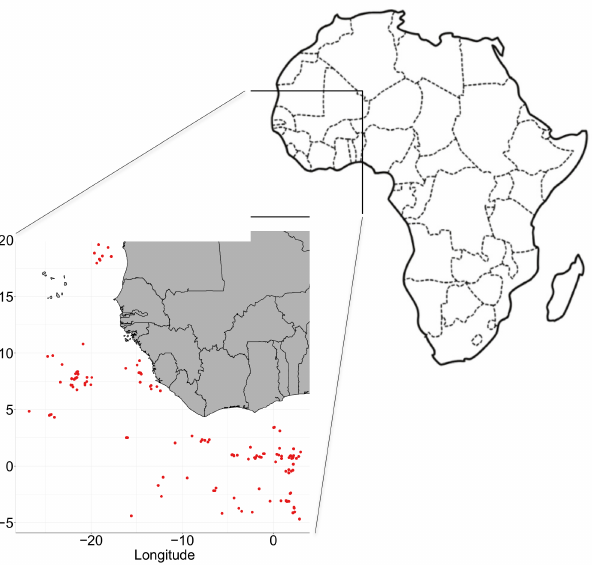
Figure 1. Fishing positions in the east Atlantic Ocean. Colored circles correspond to tuna caught from shoals near fish aggregating devices or from free swimming schools. Each fish was weighed (whole weight, in kg) and lengthed (at fork, in cm). Size ratio (SR) between the largest and smallest individuals was calculated for each species,